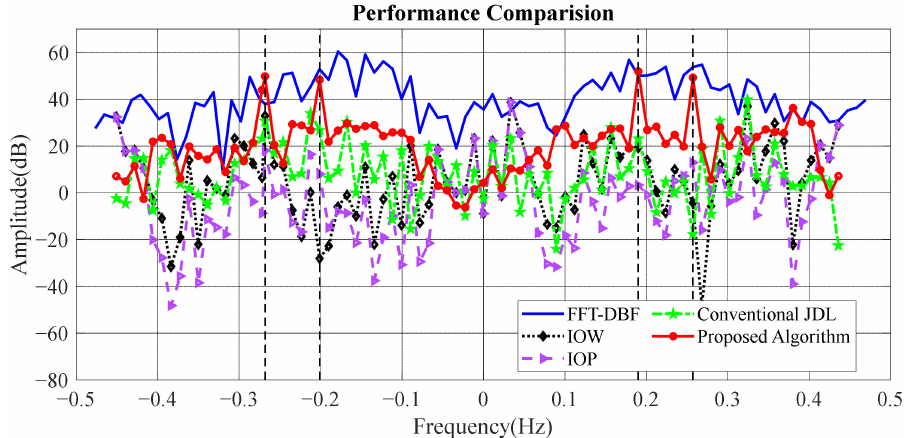
Figure 9. Comparison of Doppler profiles of the simulated targets between different algorithms.